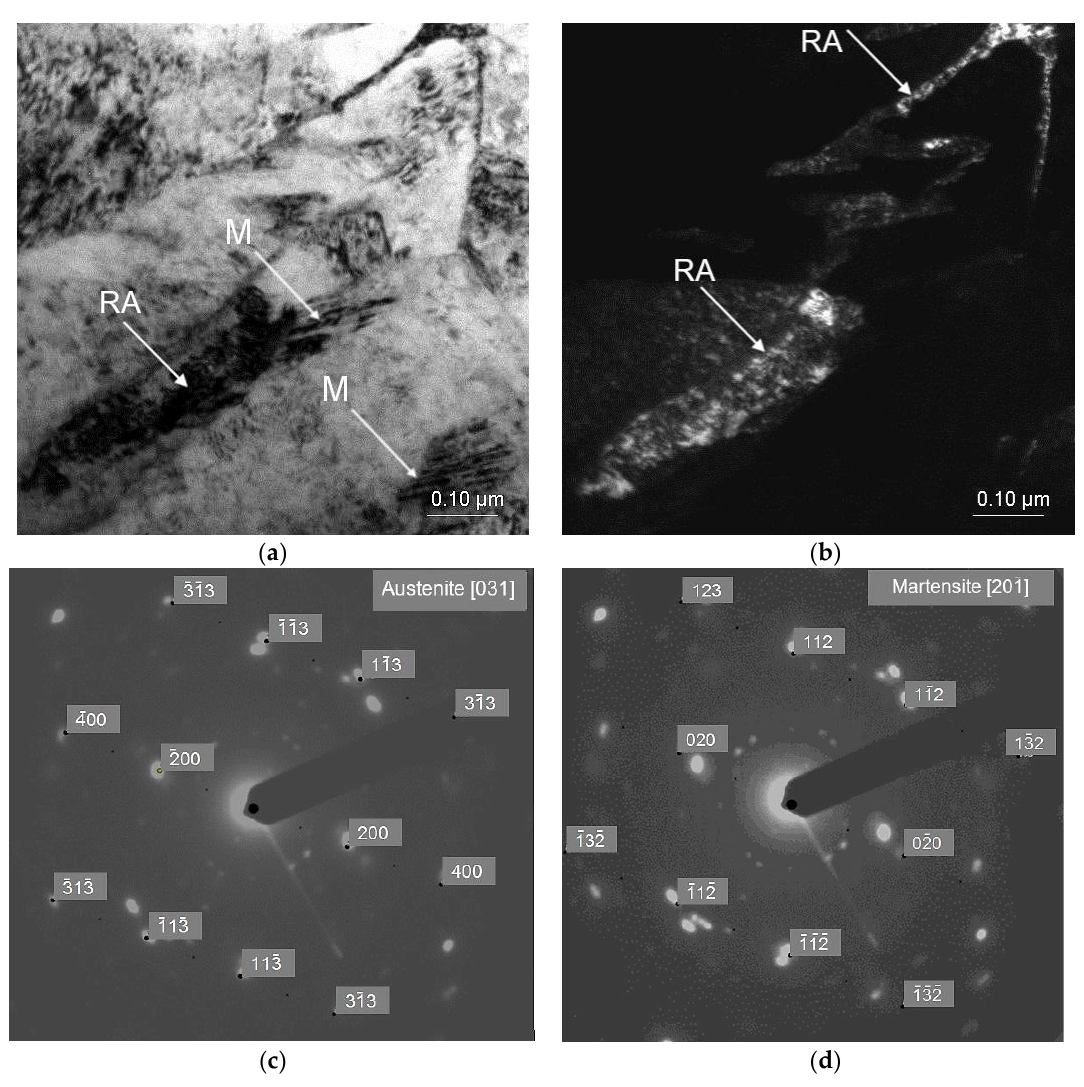
Figure 3. Elongated grain of retained austenite partially transformed into martensite in the specimen deformed at 20 °C: bright field (BF)—( a ), dark field (DF) of retained austenite ( b ), selected area diffraction pattern of retained austenite ( c ), selected area diffraction pattern of martensite ( d ).